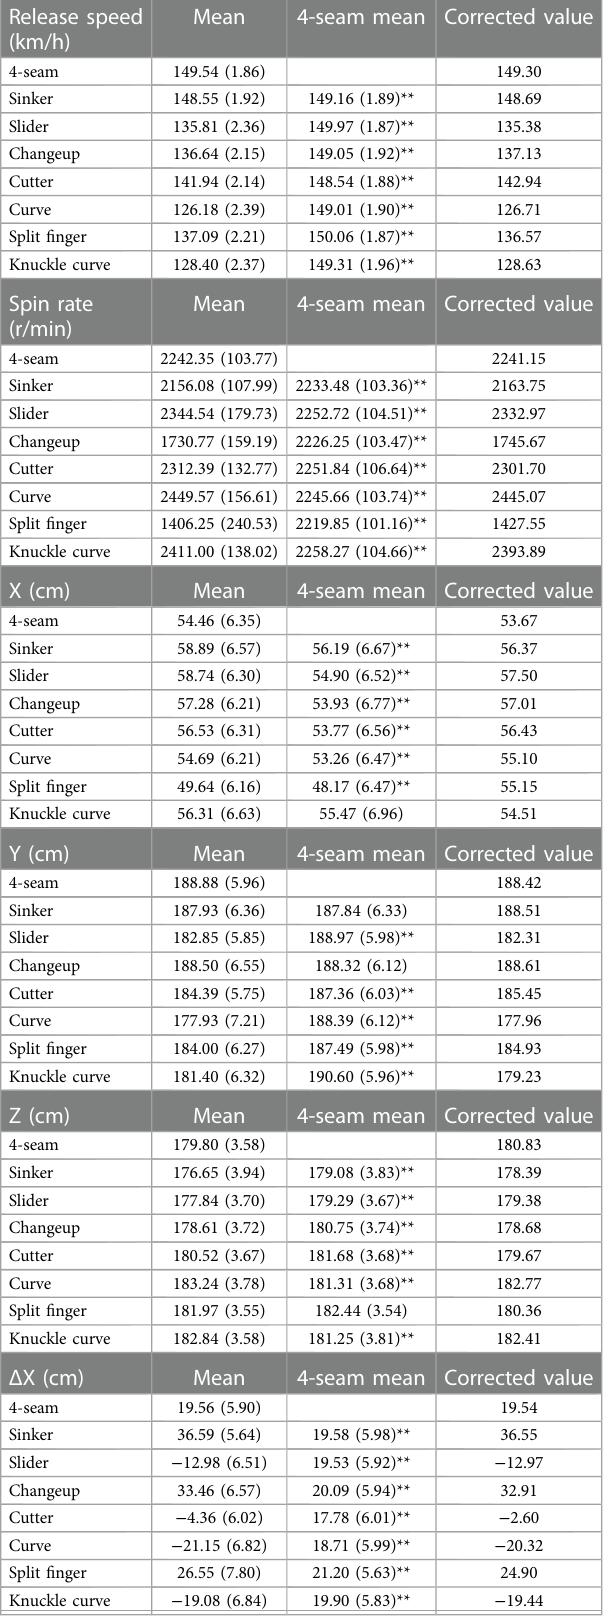
TABLE 2 Mean values of release speed, spin rate, release point 3D coordinates (X, Y, and Z axes), and amount of change ( Δ X and Δ Z) for pitch types and 4-seam mean corresponding to each ball type.